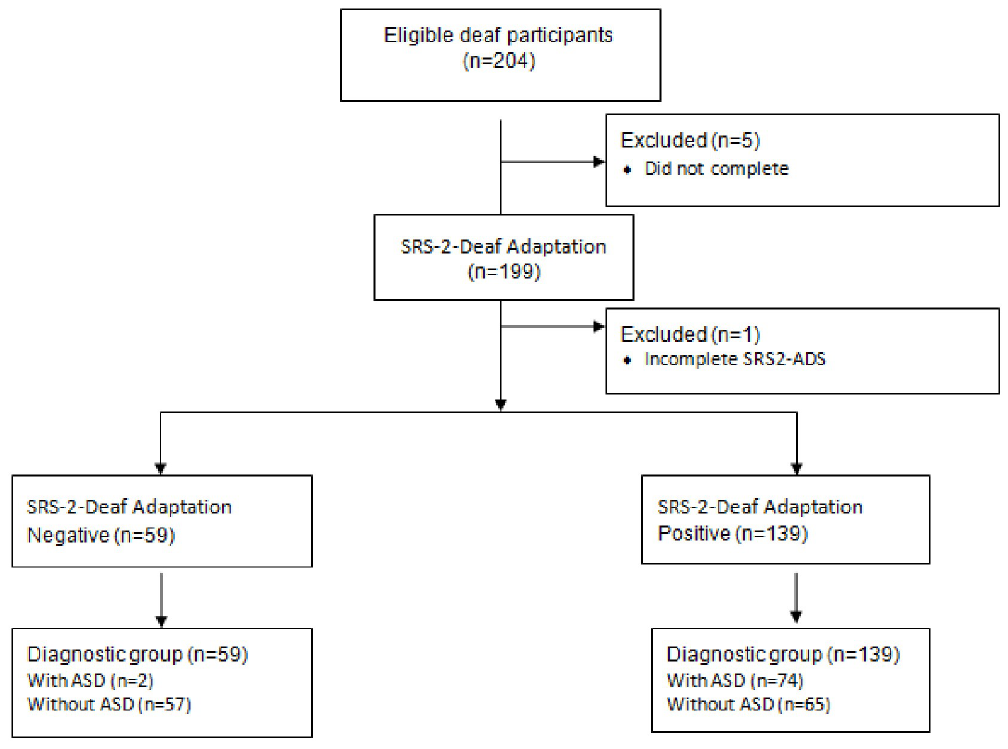
Fig 3. STARD flowchart for SRS-2 Deaf adaptation (diagnostic